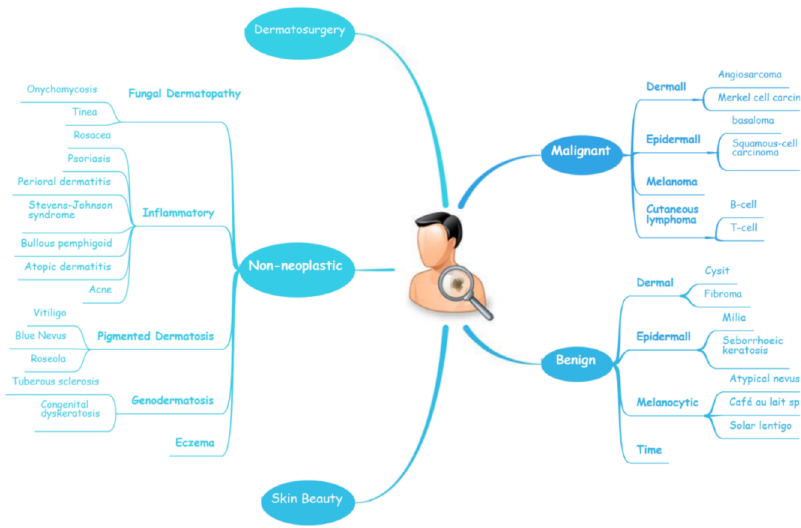
Figure 3. A schematic illustrates the hierarchy of the implementation of AI in dermatology.